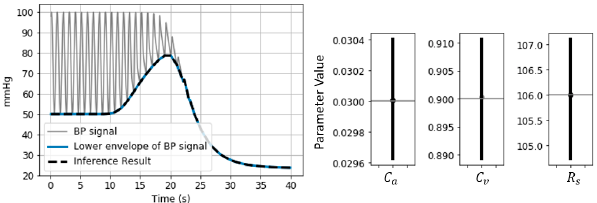
Figure 20. Simulated BP signal and inference result. The signal is simulated with control parameter values 𝐶 (cid:3028) = 0.03 mL/mmHg, 𝐶 (cid:3049) = 0.9 mL/mmHg, 𝑅 (cid:3046) = 106 mmHg·s/mL. The inferred parameter values C a = 0.03 mL/mmHg, C v = 0.9 mL/mmHg, R s = 106 mmHg · s/mL. The inferred parameter values (determined as the central tendency of corresponding posterior distributions) are equal to the control parameter values. control parameter